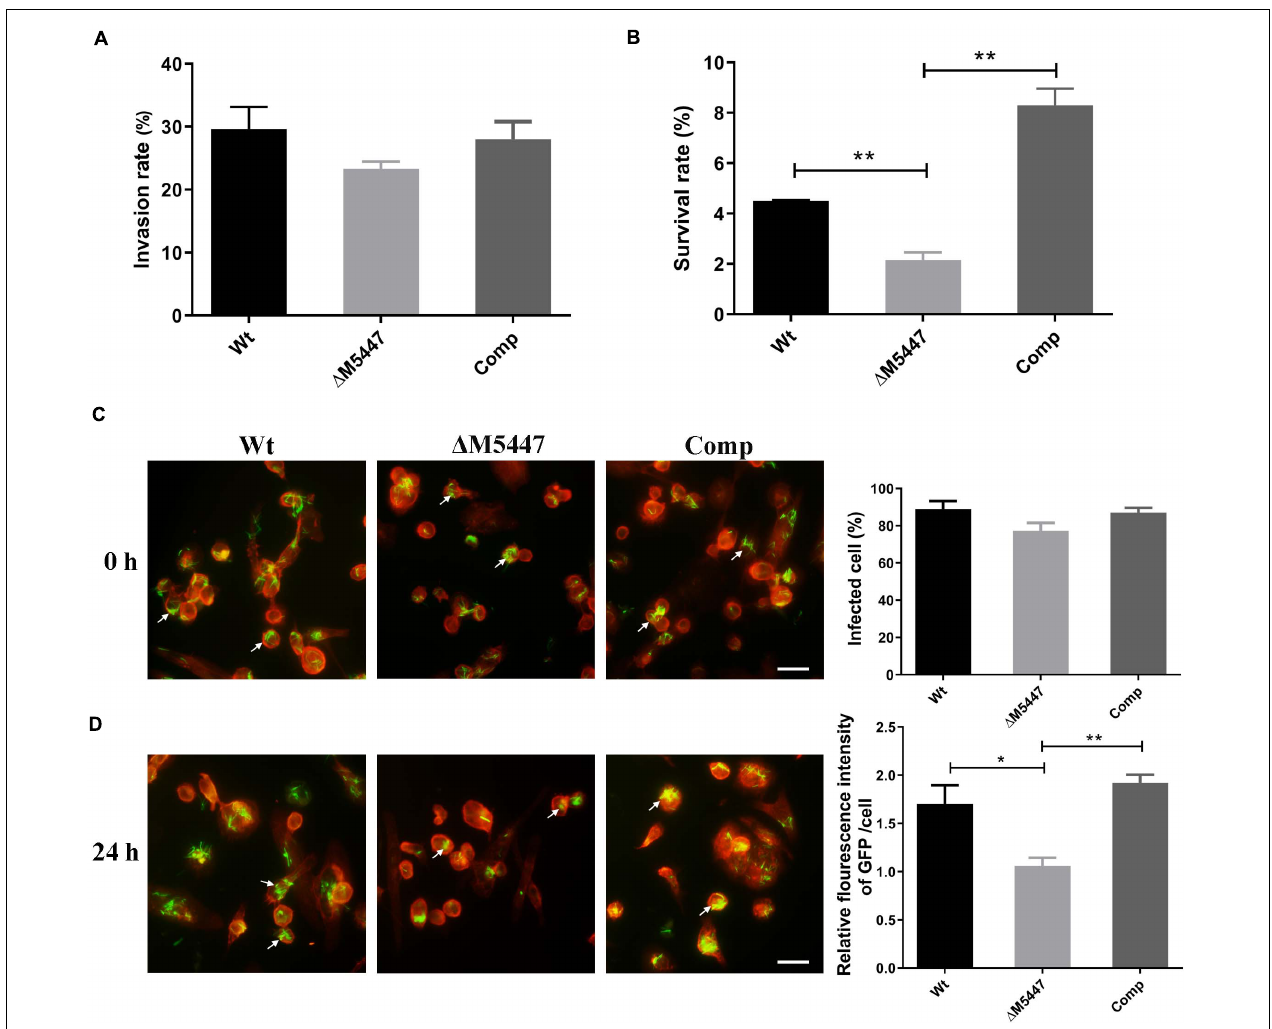
FIGURE 4 | (cid:49) M5447 displayed impairment in survival ability in THP-1 cells. The invasion ability (A) and intracellular survival (B) of different M. smegmatis strains in THP-1 macrophage were evaluated. Macrophage cells were infected with Wt, (cid:49) M5447, and Comp strains at an MOI of 10. The infected cells were lysed by 0.03% SDS at the indicated time, and the colonies were counted by CFU assay. The invasion rate of bacteria was calculated by the number of intracellular bacteria at 0 h post-infection to the number of initial bacteria for infection. The percentage of intracellular survival of bacteria was evaluated by the intracellular bacteria at 24 h post-infection to the number of 0 h of post-infection. The invasion and survival ability of bacteria in THP-1 macrophages were also determined by fluorescence microscopy. Green fluorescence protein (GFP)-expressing plasmid and rhodamine-phalloidin dye were used to visualize the bacteria and macrophage F-actin individually. (C) The bacterial invasion rate was evaluated by the percentage of cells containing GFP at 0 h post-infection. (D) The bacterial survival rate was evaluated by the relative fluorescence intensity of GFP per cell at 24 h post-infection. The white arrows indicate a representative number of intracellular bacteria. Scale bars, 20 µ m. A representative field was shown from two independent experiments. Data were shown as mean ± SD of replicate wells; statistical analyses were performed by the method of two-tailed t -test (* p < 0.05, ** p <